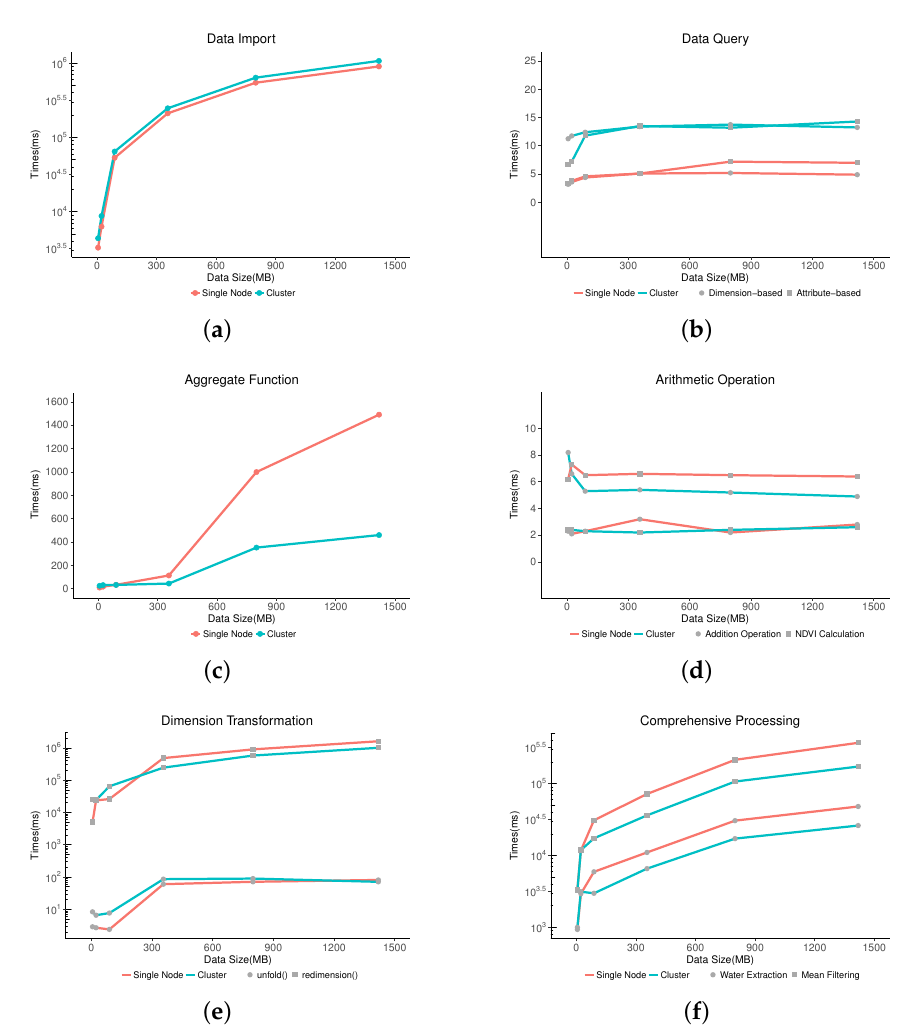
Figure 6. Performance comparison between a single node and a cluster of SciDB. ( a ) Data import; ( b ) Data query; ( c ) Aggregate function; ( d ) Arithmetic operation; ( e ) Dimension transformation; ( f ) Comprehensive